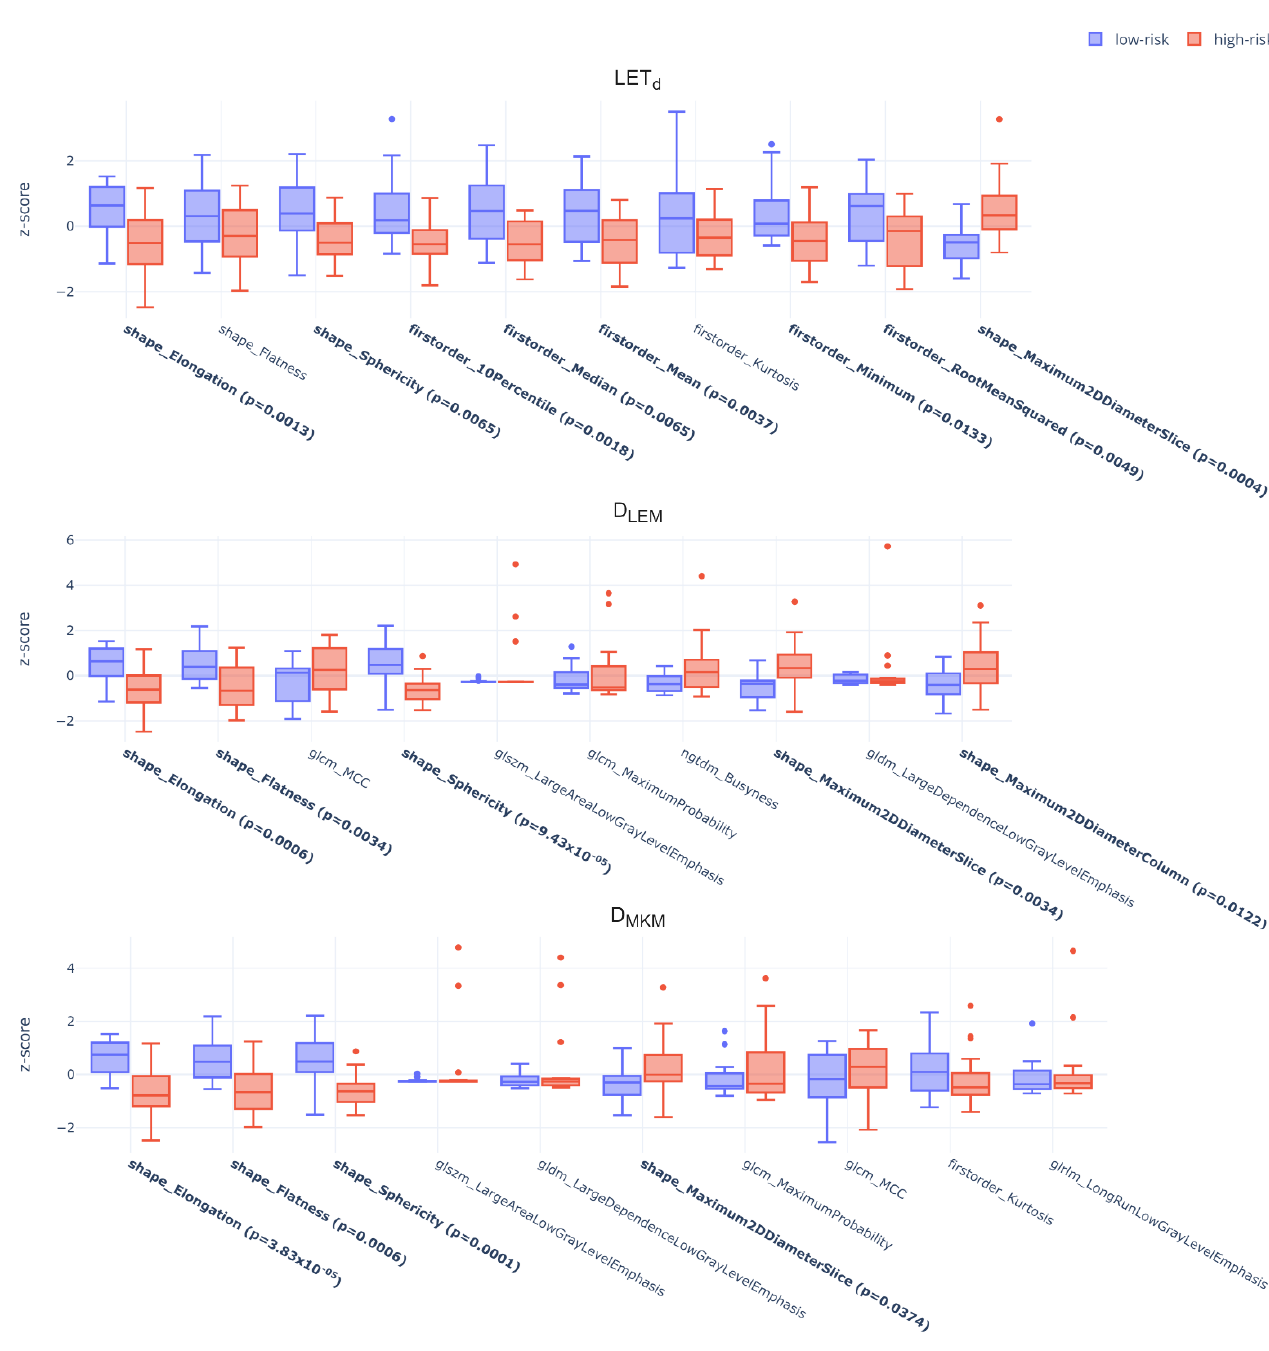
Figure 4. Standardized dosiomics features (LASSO-routine, LET d , D LEM , D MKM from top to bottom) as stratified by r-Cox according to the risk (low-risk in blue, high-risk in red) of HD-LR. Features highlighted in bold showed statistically significant differences between the two classes (Mann– Whitney U test ( α = 0.05)) and the obtained p -values are reported in brackets. Each label in the boxplot is structured as feature type (i.e., ‘shape’ for shape features, ‘firstorder’ for first order features and matrix name (e.g., ‘glcm’) for texture features) followed by the specific feature name according to PyRadiomics convention. Refer to supplementary materials Section S2 for more details.